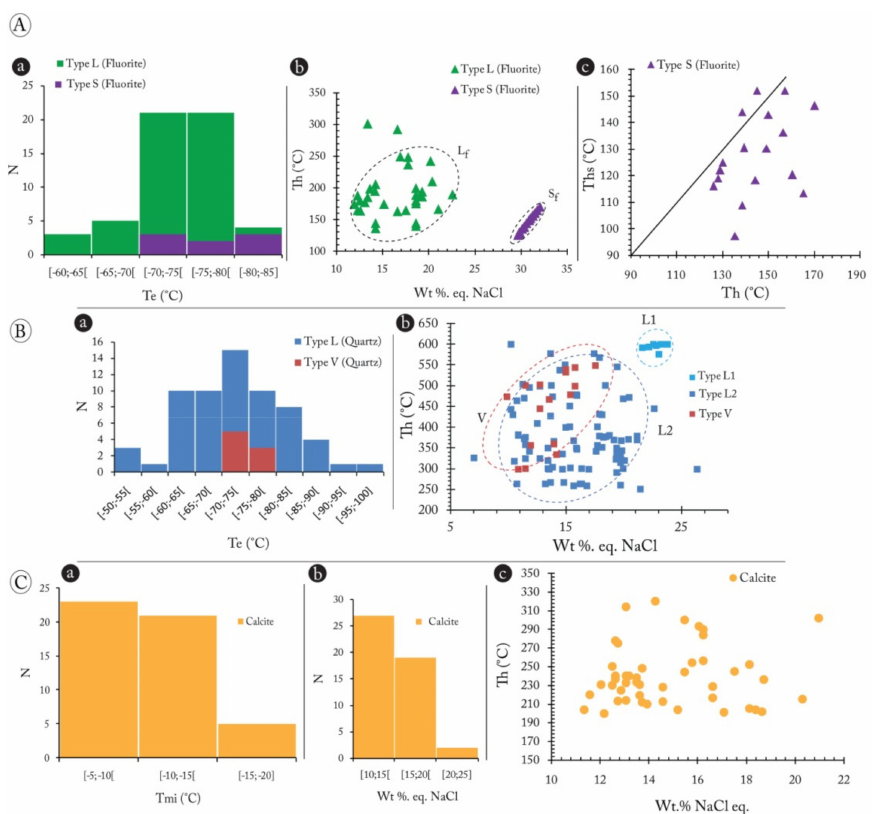
Figure 21. Analyses of different types of fluid inclusions in quartz, fluorite and calcite. ( A (a)) His- tograms of eutectic temperatures of fluid inclusions for L and S-type in fluorite; ( A (b)) salinity scatter plot—homogenization temperatures of L-type fluid inclusions offluorite; ( A (c)) scatter plot temperatures of homogenizations (SHt)-(Ht) of S-type fluid inclusions of fluorite. ( B (a)) Histogram of the homogenization temperatures (Ht) of fluid inclusions of quartz; ( B (b)) salinity scatter plot– homogenization temperature of L and V-type fluid inclusions of quartz. ( C (a)) Histogram of ice- melting temperatures (IMT); ( C (b)) salinity of L-type fluid inclusions of calcite; ( C (c)) salinity scatter plot– homogenization temperatures of L-type fluid inclusions of calcite. L: Liquid; V: Vapor; S: Solid.